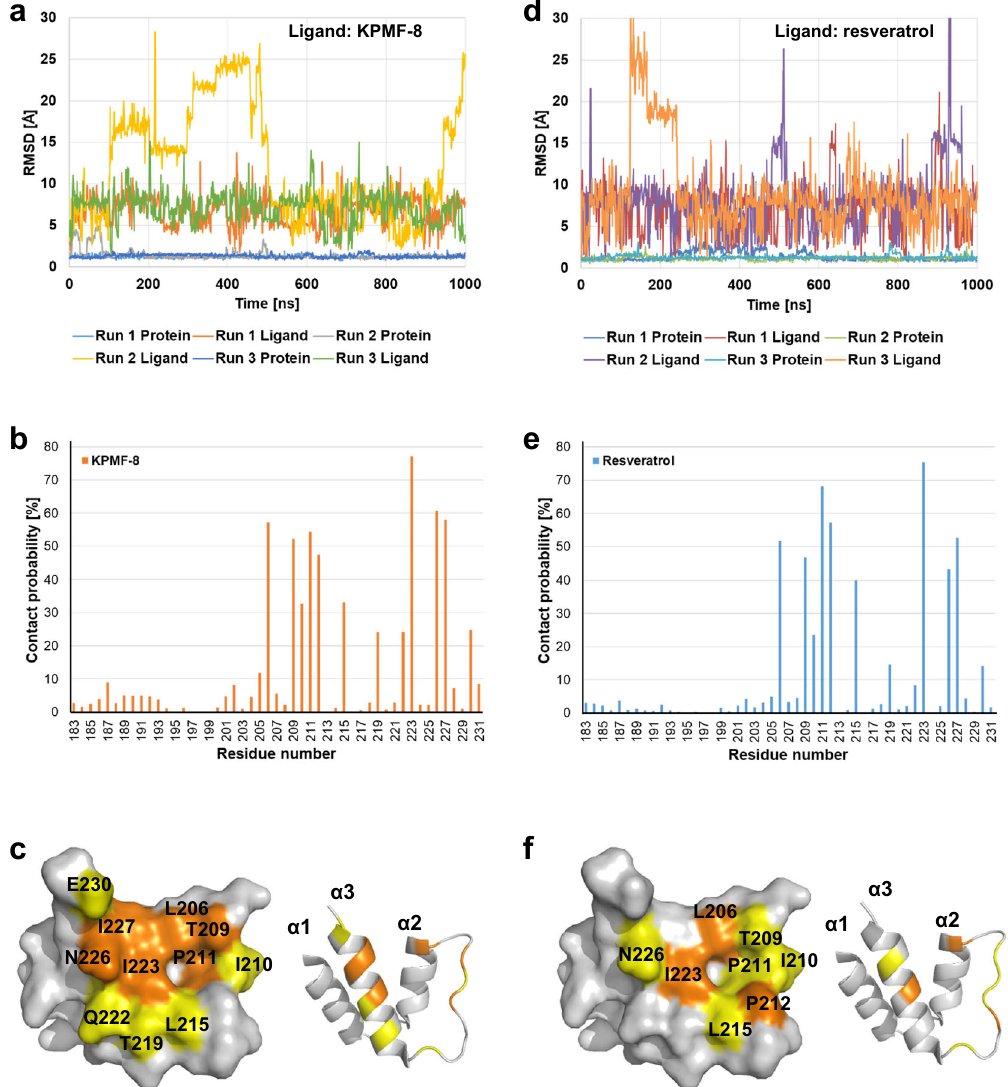
Fig. 7 RMSD values of SIRT1 NTD – KPMF-8 and SIRT1 NTD-resveratrol models as determined by MD simulations. a SIRT1 NTD – KPMF-8 model. d SIRT1 NTD-resveratrol model. RMSD values were calculated for C α atoms of the protein and non-hydrogen atoms of the ligands using the docking models as the reference structures after aligning the C α atoms of the protein of the MD structures to those of the docking models. Contact probabilities of each residue